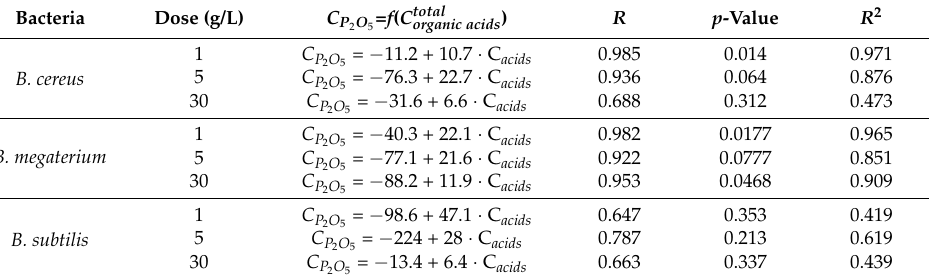
Table 4. The relationship between the total organic acid concentration and P 2 O 5 concentration in the